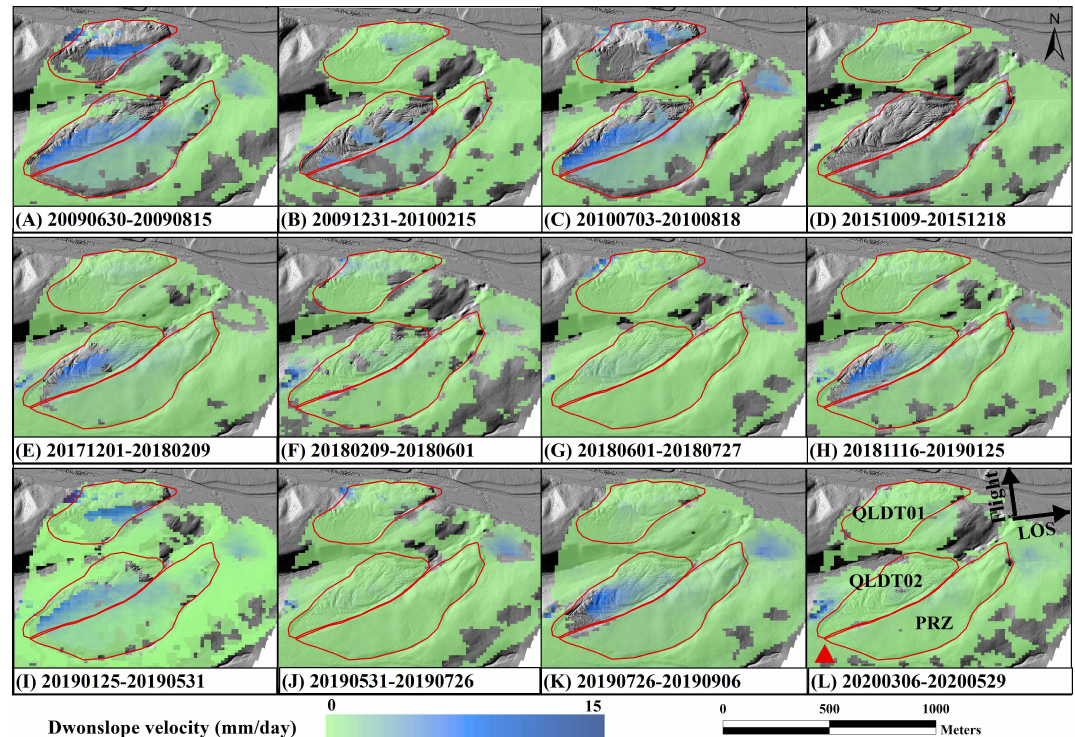
Figure 5. The downslope velocity is derived from line-of-sight (LOS) deformation using Equation (2). The background map is the shaded relief map derived from UAV DEM. The twin landslides (QLDT01 and QLDT02) and the potential risk zone (PRZ) are marked by red polygons in the bottom right-hand corner of the subfigures. The positive values refer to the movement in the downslope direction. The red triangle denotes the location of the reference